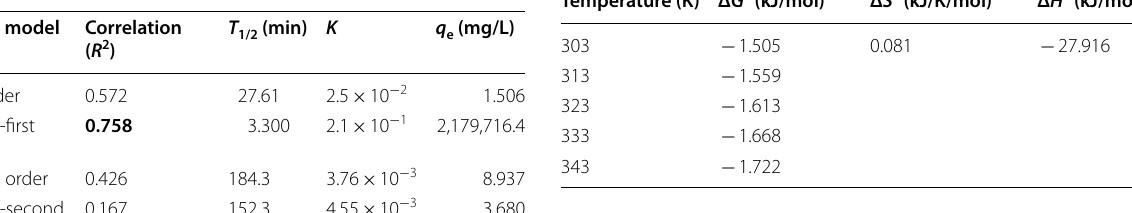
Table 3 Kinetic parameter for hexavalent